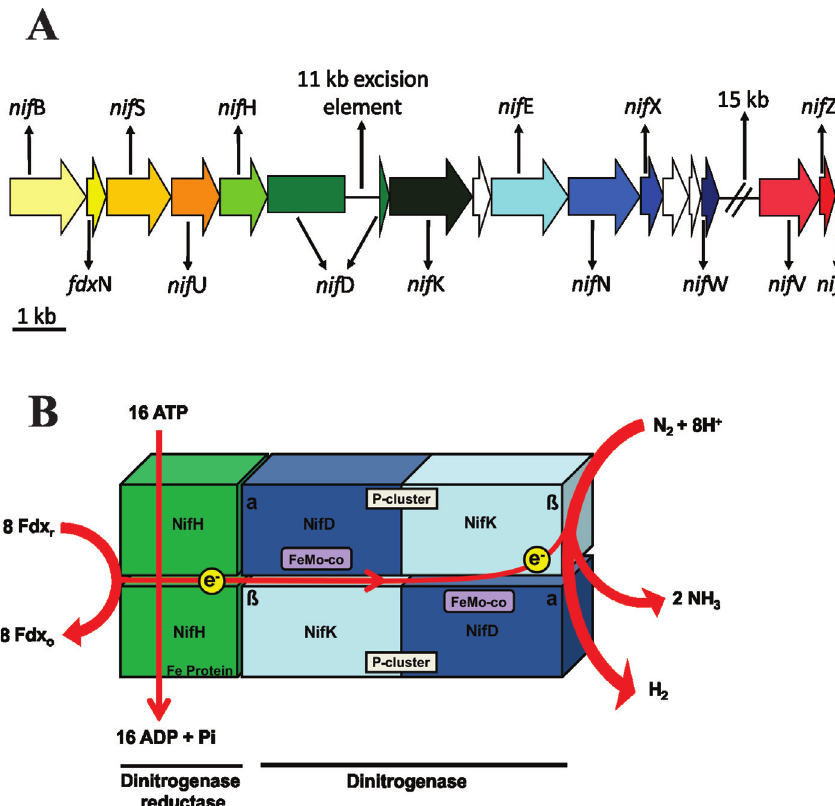
Figure 2 - Nitrogenase gene structure. (A) Map illustrating two of the nif gene clusters present in Anabaena variabilis ATCC29413. The operons are rep- resented using different colours: yellow ( nif B- fdx N- nif SU), green ( nif HDK), blue ( nif ENXW) and red ( nif VZT). White arrows indicate genes which en- code proteins with unknown functions. The 11-kb excision element observed in the nif HDK operon is not present in the chromosomes of heterocytes. nif VZT is part of a second nif gene cluster. (B) Nitrogenase structure and biochemical activity. Dinitrogenase reductase is a homodimer (2x30 kDa) with one [4Fe-4S]-cluster (Fe protein) encoded by nif H, whereas dinitrogenase is a FeMo-protein encoded by the genes nif D ( (cid:2) -subunit) and nif K ( (cid:3) -subunit) and organized in a (cid:2) 2 (cid:3) 2 tetramer of 240 kDa associated with two FeMo-cofactors (FeMo-co) and two P-clusters. Notably, there are three types of